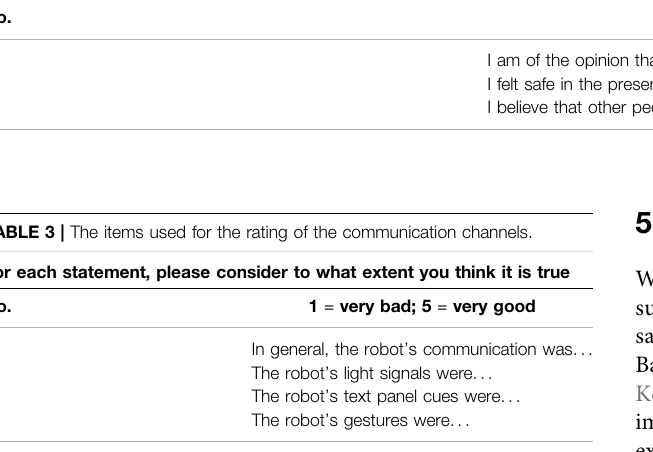
TABLE 2 | The items for the perceived safety scale are based on the scale by Lasota et al. (2017). For each statement, please consider to what extent you think it is true No.